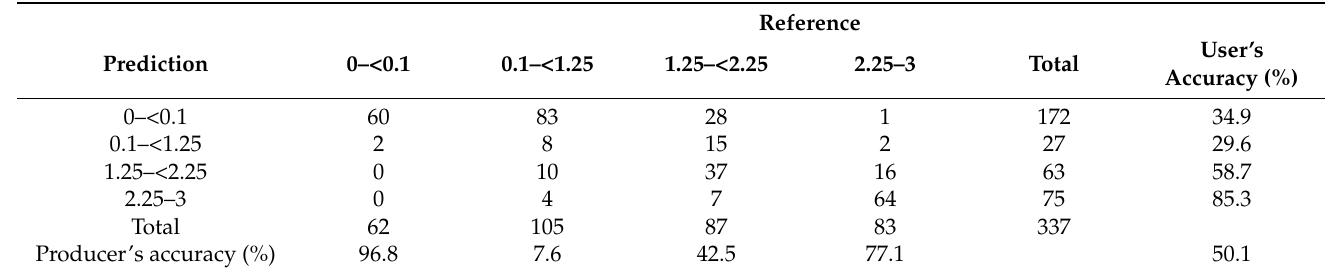
Table A16. Confusion matrix for current (Miller et al., 2009) model prediction EA CBI with Landsat RdNBR with offset.